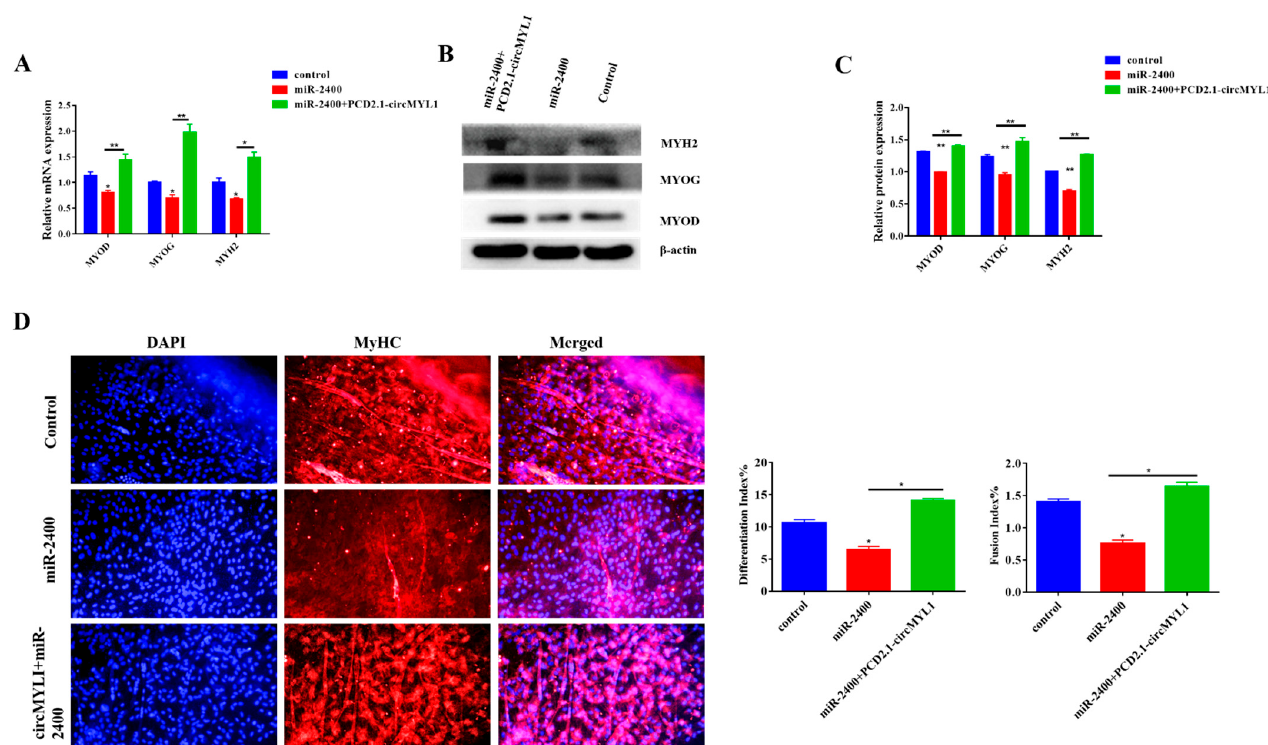
Figure 7. The effect of miR-2400 on the differentiation of myoblasts. ( A ) Bovine primary myoblasts were transfected with miR-2400 mimic and/or circMYL1 overexpression vector, and qRT-PCR detected the relative expression levels of differentiation marker genes MyoD , MyoG , and MYH2 . ( B ) Western blot detected the protein expression levels of differentiation marker genes MyoD , MyoG , and MYH2 . ( C ) Histogram graph showing the protein band density evaluated using ImageJ. ( D ) Immunofluorescence detected MyHC (red)-positive myotubes after transfected the bovine primary myoblasts with miR-2400 mimic and/or circMYL1 overexpression vector, and they were detected under a fluorescence microscope: scale bar, 200 μ m, and the differentiation index and fusion index were counted. Data are shown as mean ± SEM. n = 3. * p < 0.05; ** p < 0.01.